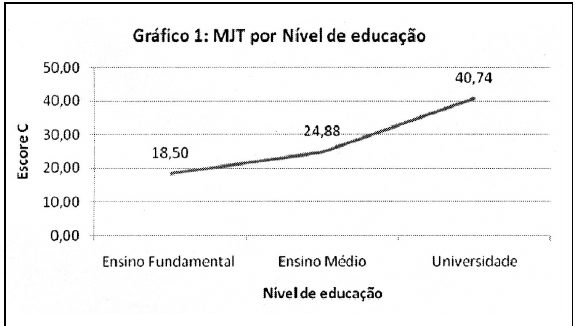
Figura 1 . MJT por nível de educação (Bataglia, 2001)